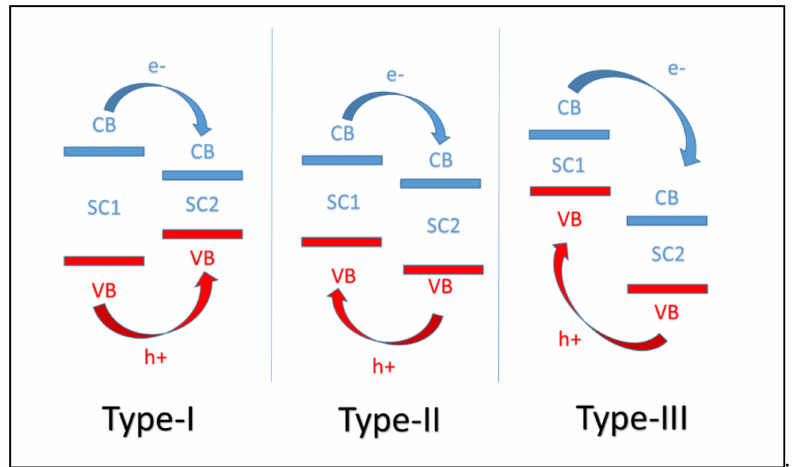
Figure 4. Three different types of semiconductor